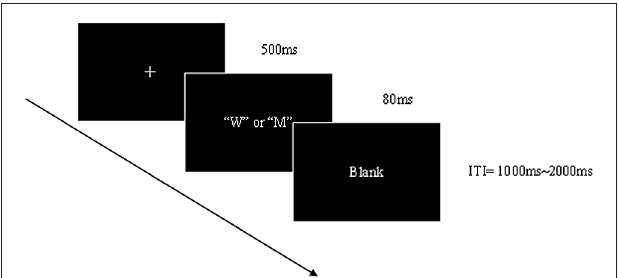
FIGURE 1 | Sequence of events in